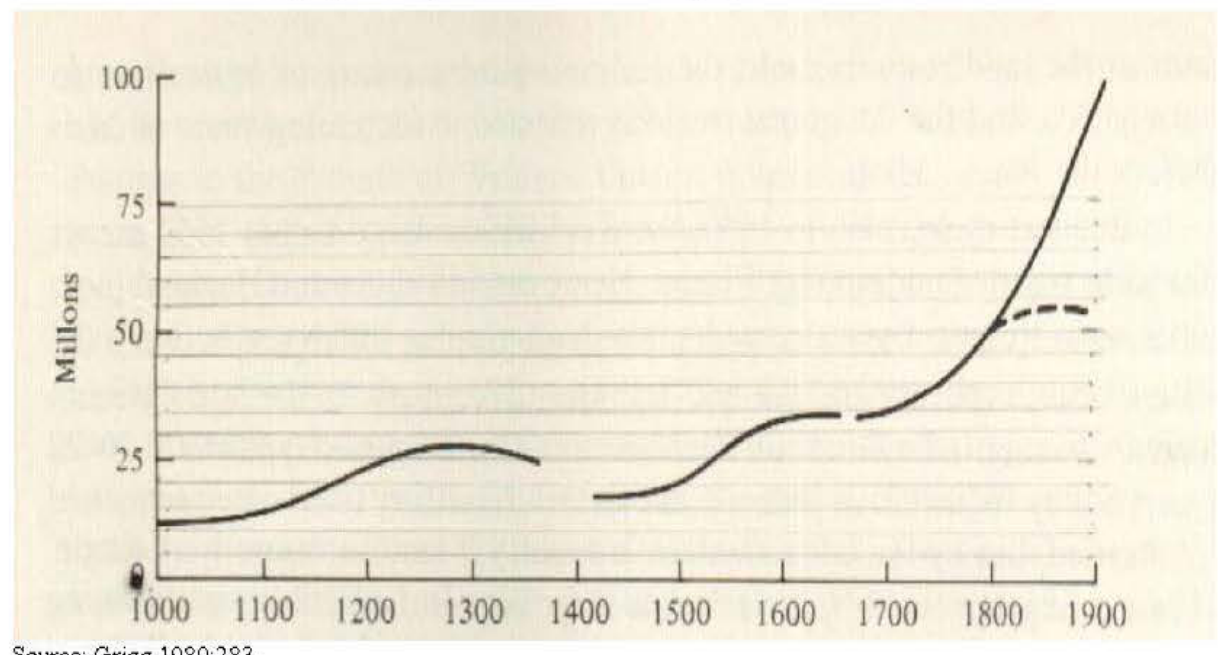
Figure 2. A schematic representation of population growth in Western Europe. Continuous line: total population; broken line: rural